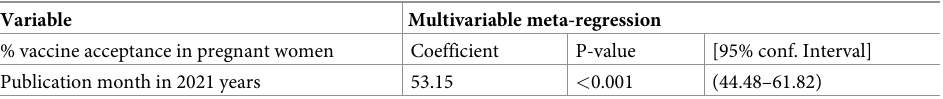
Table 2. Meta-regression analysis of the effect of the factors on vaccine acceptance in pregnant